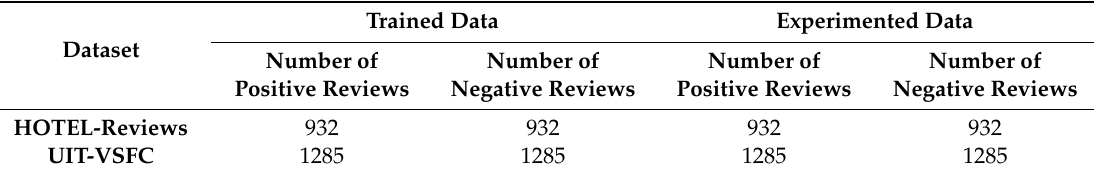
Table 5. Information details about two datasets used in experiment.